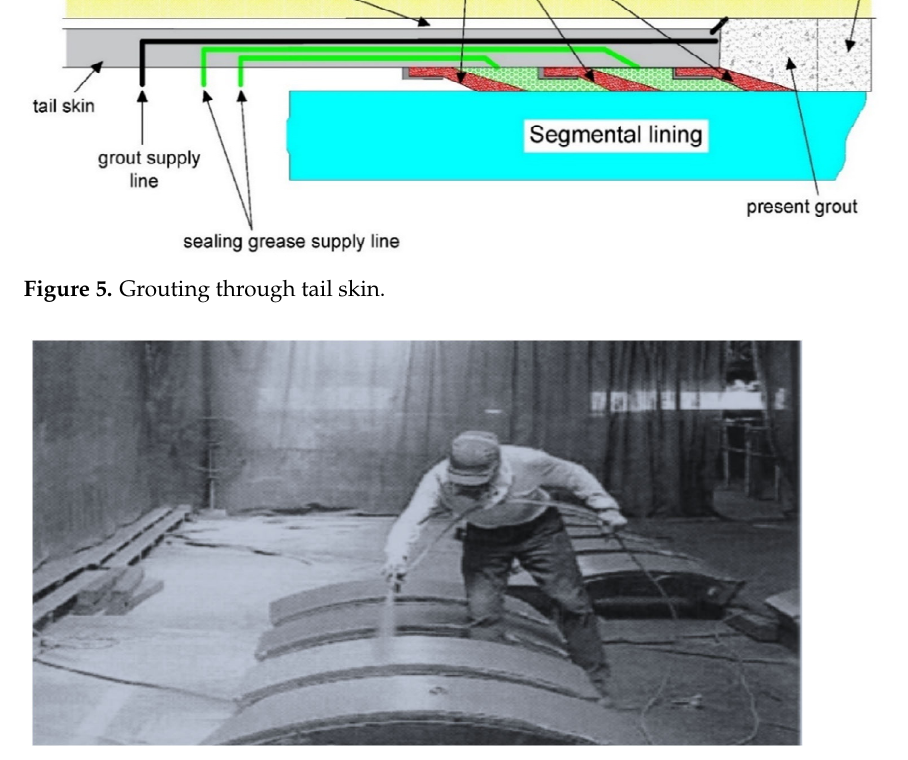
Figure 6. Spray coating of paint on shield segments.